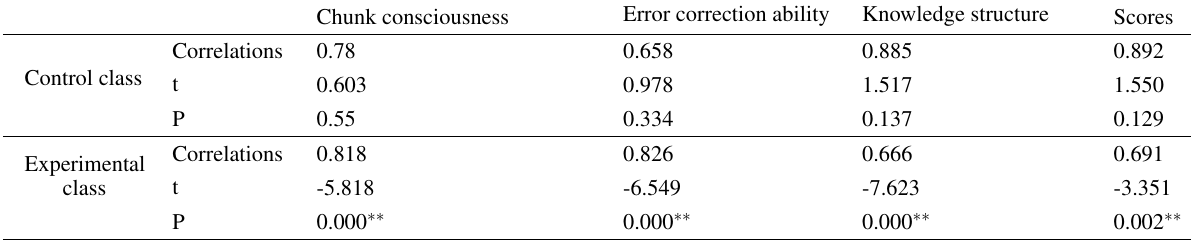
Table 2 Comparison of knowledge chunk abilities and scores after